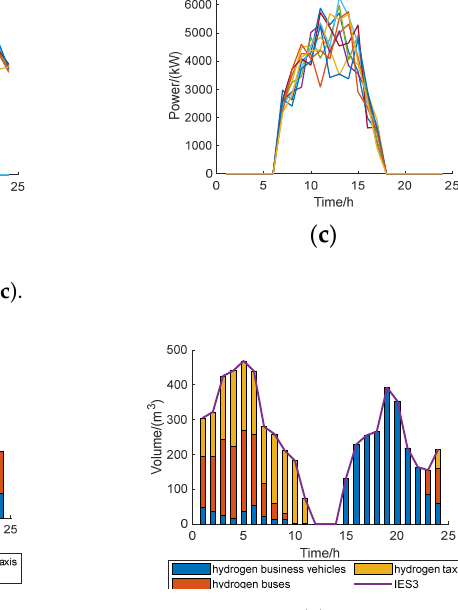
Figure 6. IES cluster charging hydrogen prediction for HICEVs, IES1 ( a ), IES2 ( b ), and IES3 ( c ).